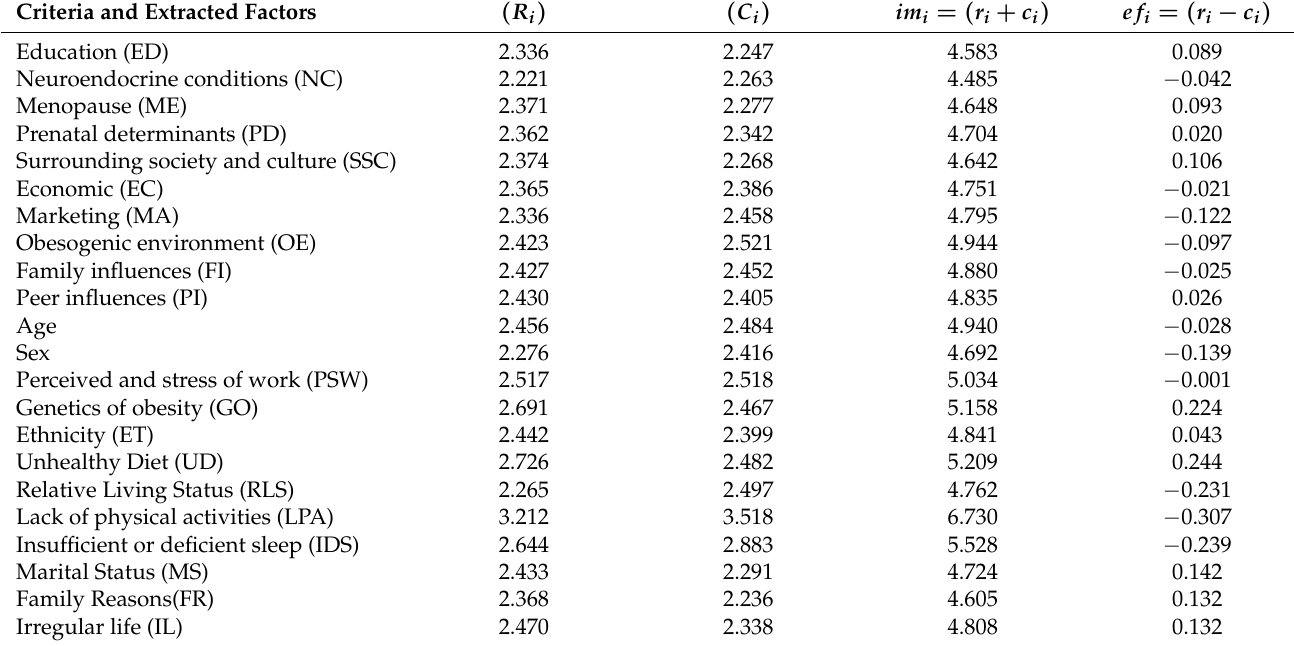
Table 5. The DEMATEL technique for ranking of defined